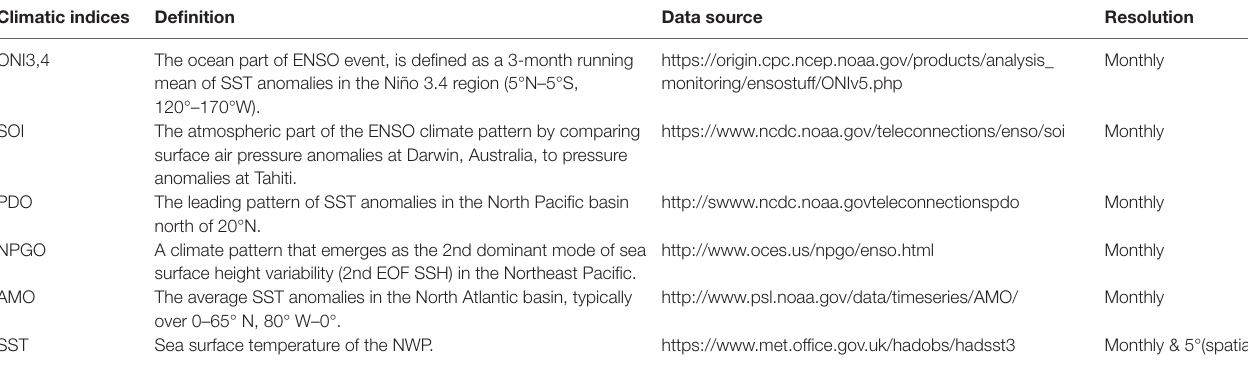
TABLE 1 | The definition and sources of climatic